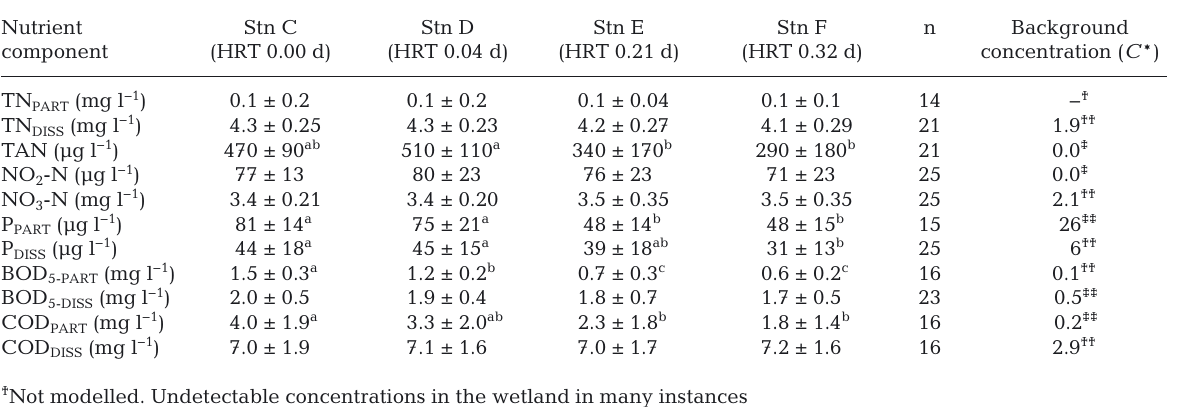
Table 2. Mean (±SD) yearly net concentrations (for n sampling days) of the different dissolved (DISS) and particulate (PART) in- organic nutrients and organic matter components (TN: total nitrogen; TAN: total ammonia nitrogen; NO 2 -N: nitrite-nitrogen; NO 3 -N: nitrate-nitrogen; P: phosphorus; BOD 5 : 5 d biochemical oxygen demand; COD: chemical oxygen demand) measured at increasing hydraulic retention time (HRT; in d) along the wetland, as well as the background concentrations ( C* ) used for